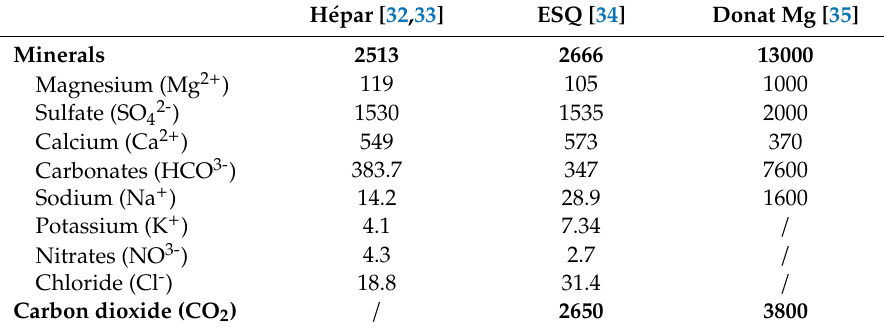
Table 4. Mineral content (mg / L) of the studied natural mineral